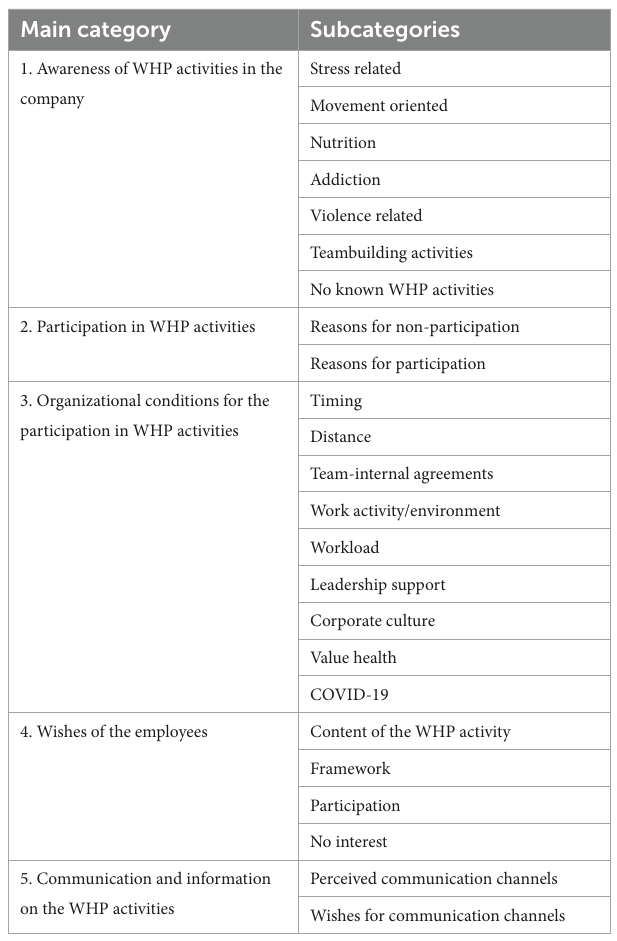
TABLE 3 Category system with defined main categories and